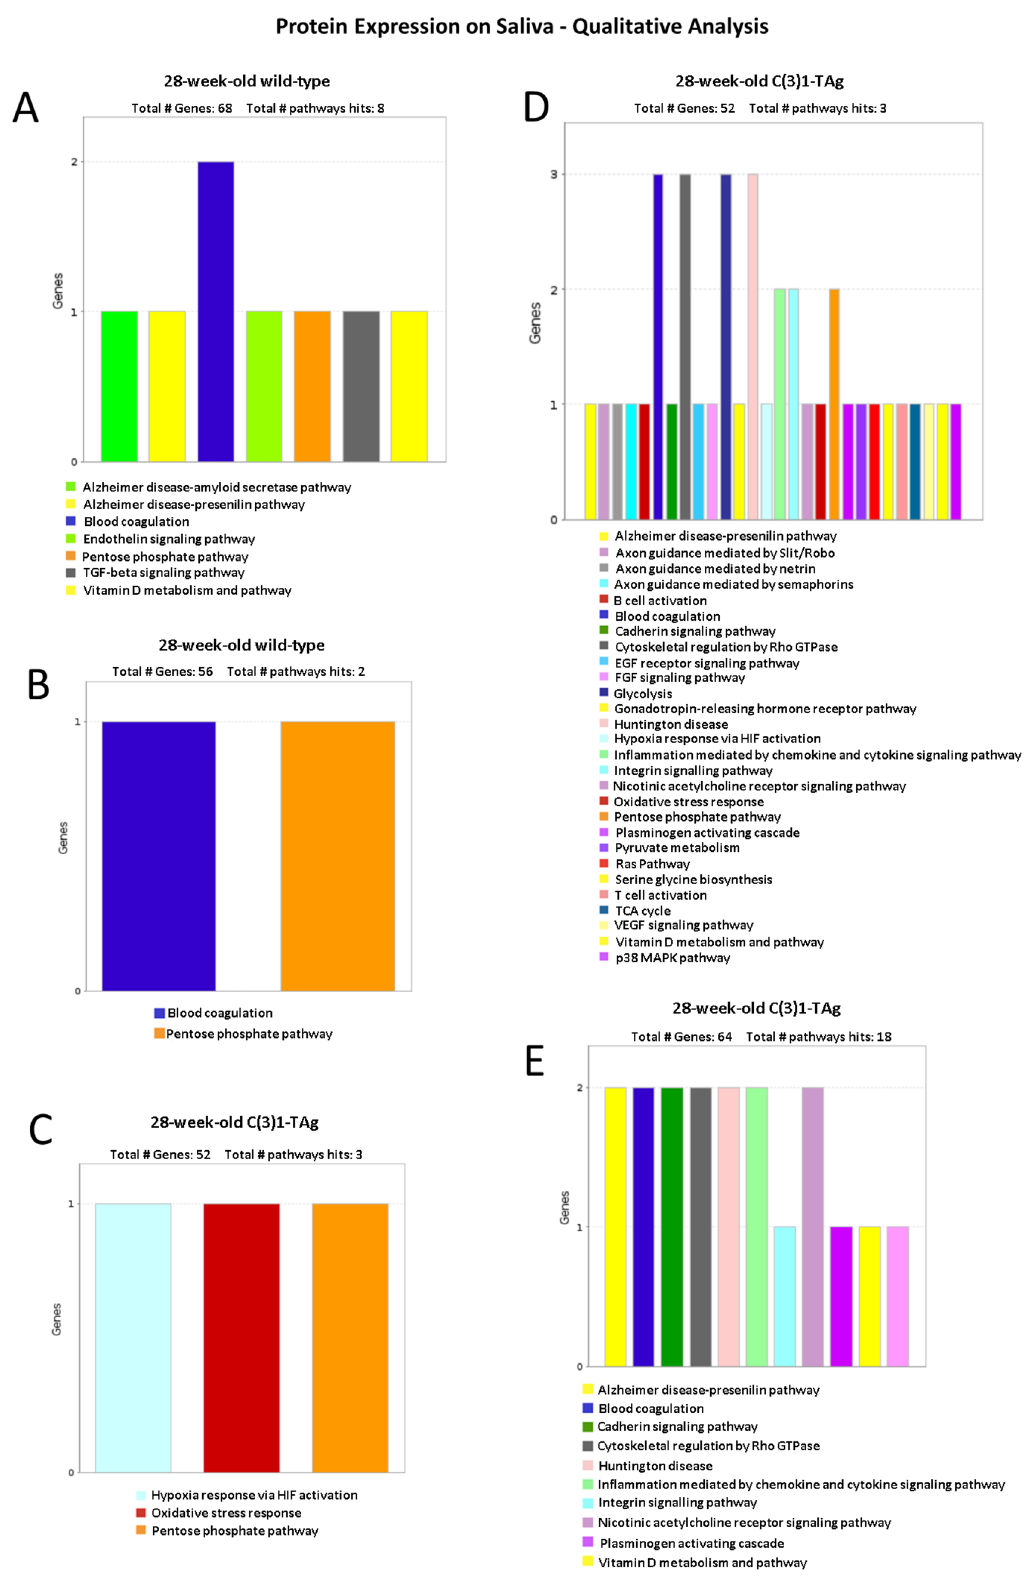
Figure 4. Qualitative pathway analysis of proteins expressed in the saliva of 28-week-old wild-type mice ( A , B ) and ( C – E ) C3(1)-TAg mice. The graphs obtained by the Panther software show a singular profile of protein expression of each animal, with one wild-type mice that could not be classified in Panther